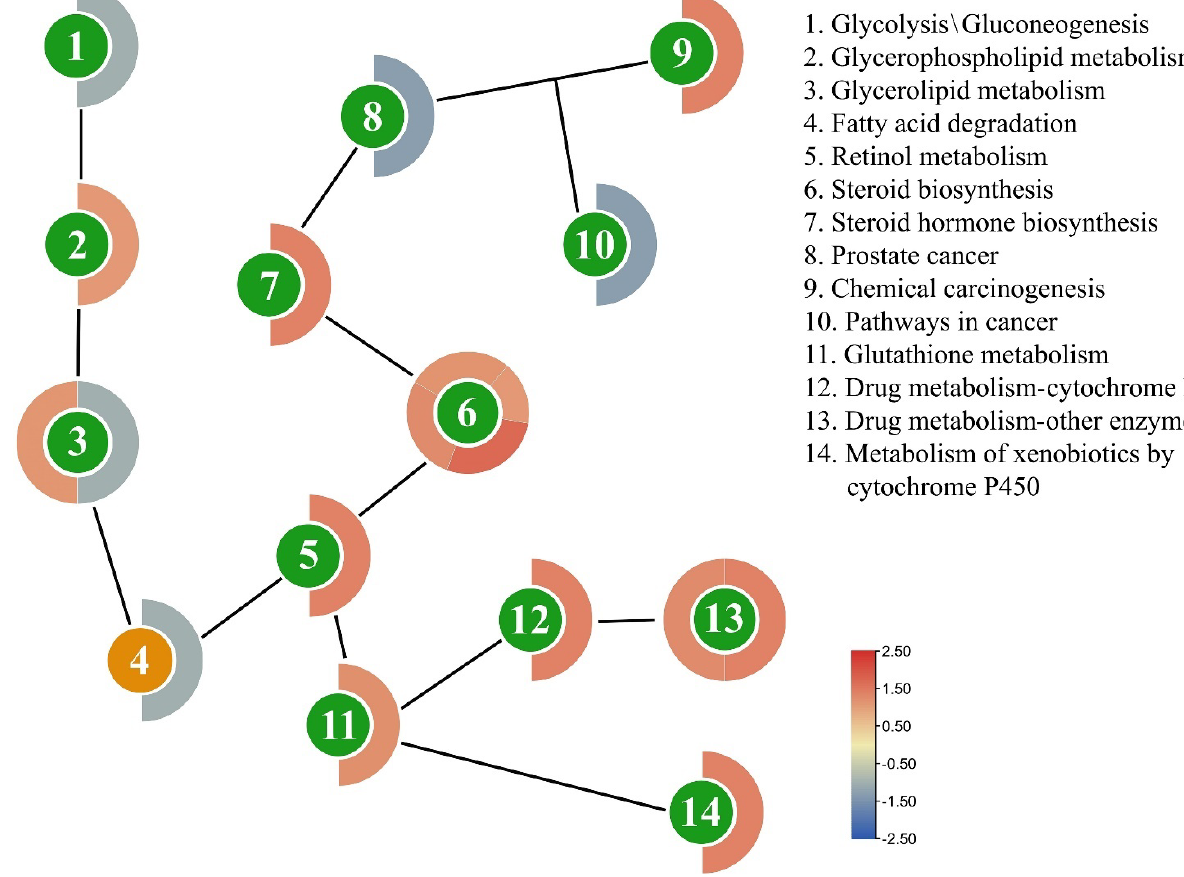
Figure 5. Scheme of the different pathways in the chain affected by the exposure of indoxacarb (after 24 h). The circle’s color indicates the pathway’s function, whereas the strip’s color outside the circle indicates how DEGs are regulated on a